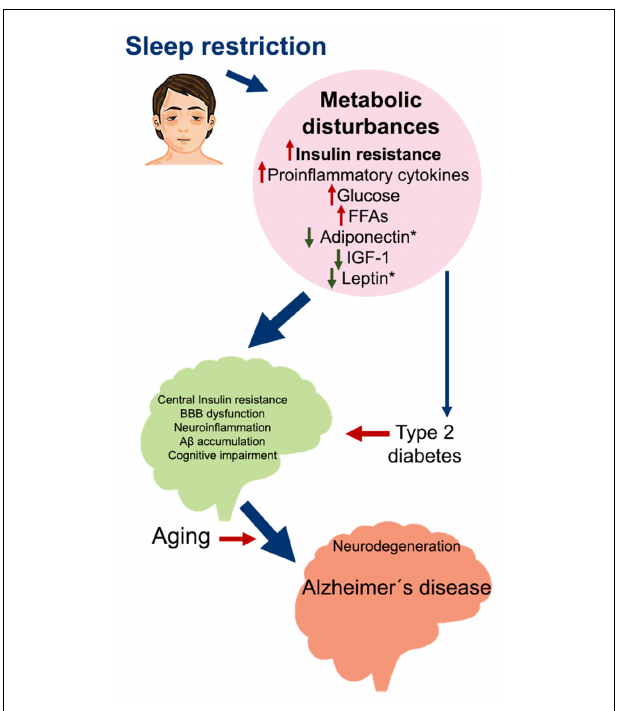
FIGURE 2 | Metabolic impairment induced by sleep restriction in the development of Alzheimer’s disease. Proposed sequence of events that may trigger Alzheimer’s disease as a consequence of chronic sleep restriction. Sleep restriction induces several metabolic disturbances in the periphery, including insulin resistance; increased proinflammatory cytokines, glucose, and FFA; and decreased adiponectin, IGF-1, and leptin. These changes can promote several alterations in the brain, such as central insulin resistance, BBB dysfunction, neuroinflammation, A β accumulation, and cognitive impairment. At the same time, persistent metabolic disturbances may develop into Type 2 diabetes, which is also associated with the same brain alterations. On top of this, aging broadens the risk for developing Alzheimer’s disease and probably other neurodegenerative diseases. Abbreviations: